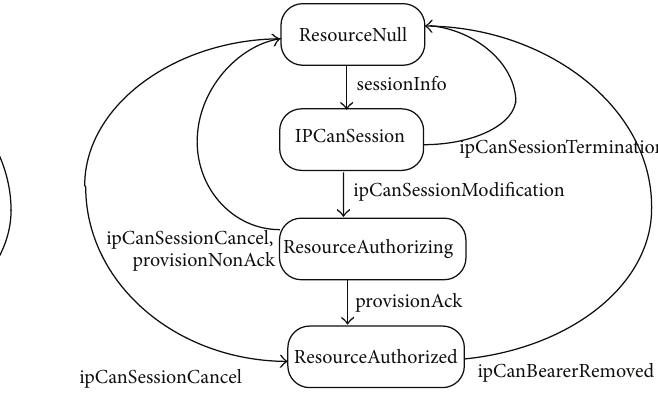
Figure 8: QoS resource state